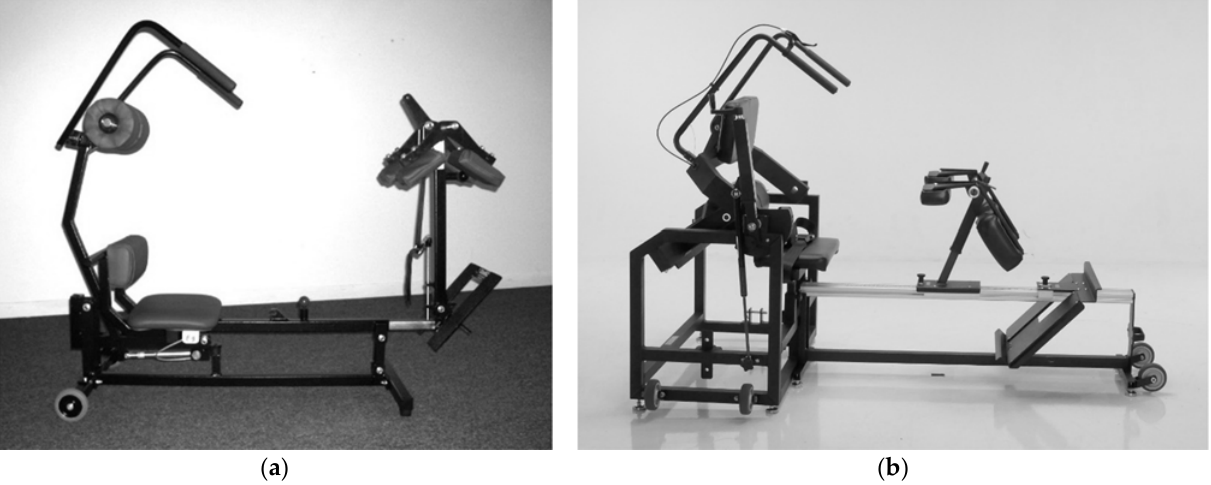
Figure 2. Home Back Extension Exercise Device (MedX Home Back Device, Converge Medical Tech- nology LLC, Austin, TX, USA). ( a ) Prototype assessed in study. ( b ) Current version.